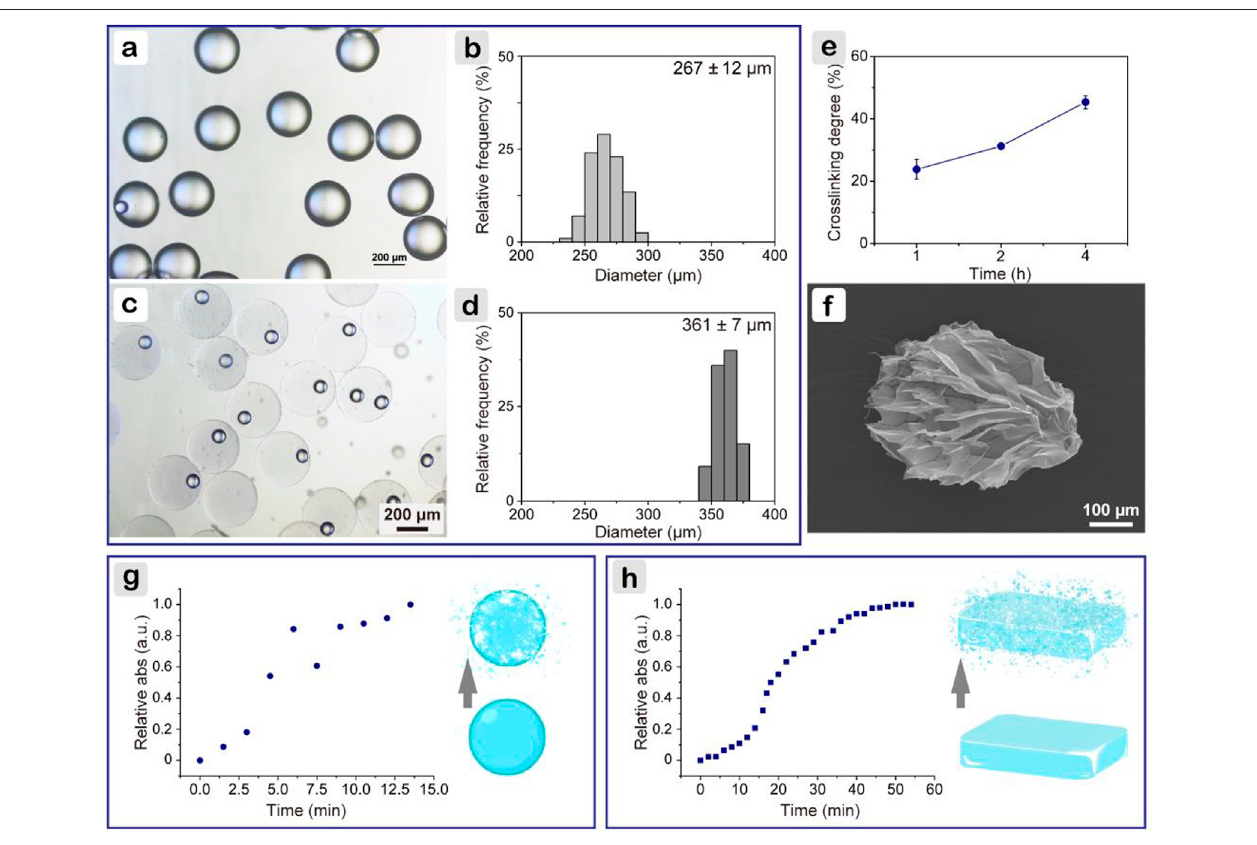
FIGURE 1 | Characterizations of gelatin microspheres. (A) Light microscope image of microspheres in precooled peanut oil, and (B) corresponding particle size distribution; (C) after cross-linking for 1 h, and (D) corresponding particle size distribution; (E) cross-linking degree of gelatin microspheres; (F) scanning electron microscope image of gelatin microsphere after lyophilization; change of relative absorbance at 590 nm for microspheres (G) and bulk hydrogel (H) with proteinase degradation time.